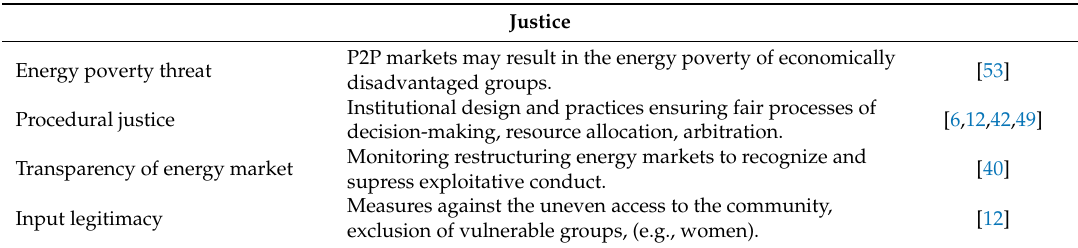
Table 6. Justice-related progression